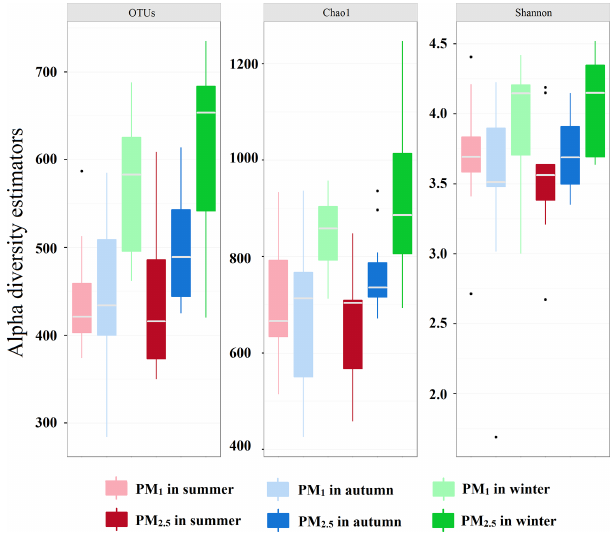
Figure 2. Statistical comparisons of OTUs, and Chao1 and Shannon indices among summer, autumn, and winter in PM 2 . 5 and PM 1